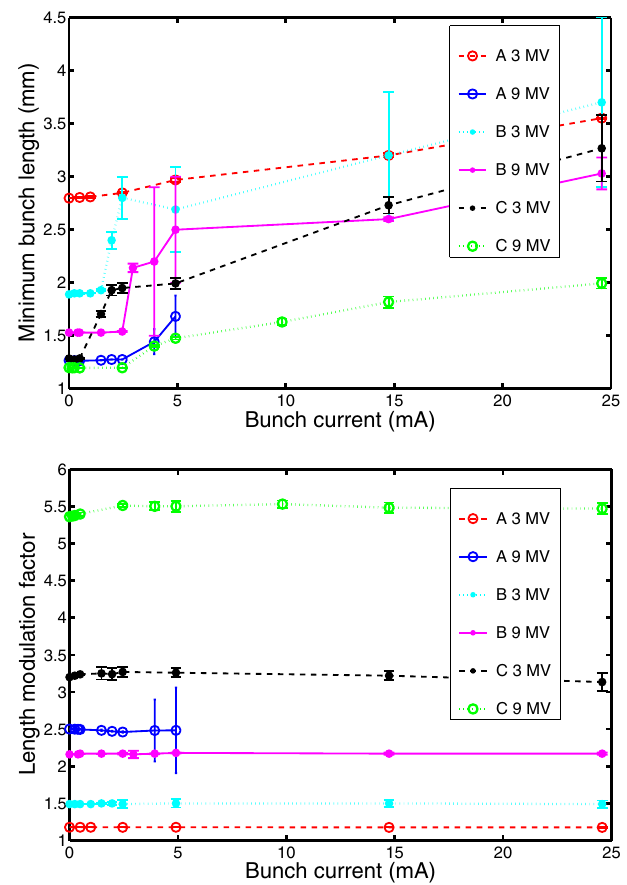
FIG. 14. (Color) Minimum bunch length and length modulation factor as a function of current up to 25 mA, under the effect of the CSR wakefields only.